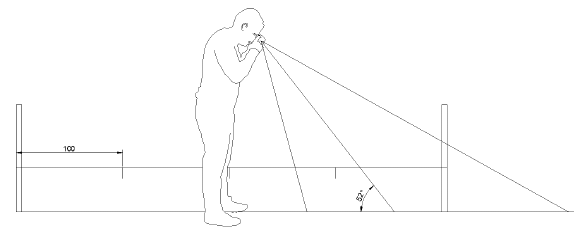
Figure 6. Data capturing setup for 1 m 2 area, showing a 52º of convergence.